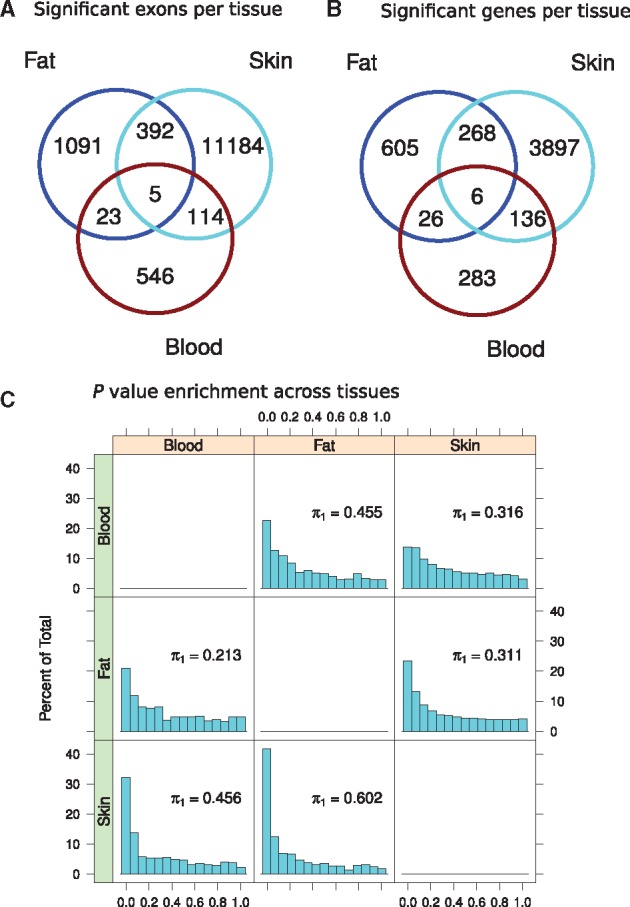
Tissue shared and specific effects of aging in gene expression changes with age. The top venn diagrams show (A) the number of exons (left) and (B) number of genes (right) significantly associated with chronological age in fat, skin and whole blood. Five exons were commonly associated to age in the three tissues. LCLs were not included, as only 7 exons were significantly associated with age. (C) The P values of significant exons associated with age in one tissue were extracted from the analysis in the other tissues for enrichment analysis (π1). The histograms show the P values for association between expression and age in one tissue (left, green color) if the exons were significantly associated exons in another tissue (top, orange color). As shown in the graphs, age-related signals detected in fat shared an estimated 60.2% of the age effect signal skin tissue and 45.6% with blood.